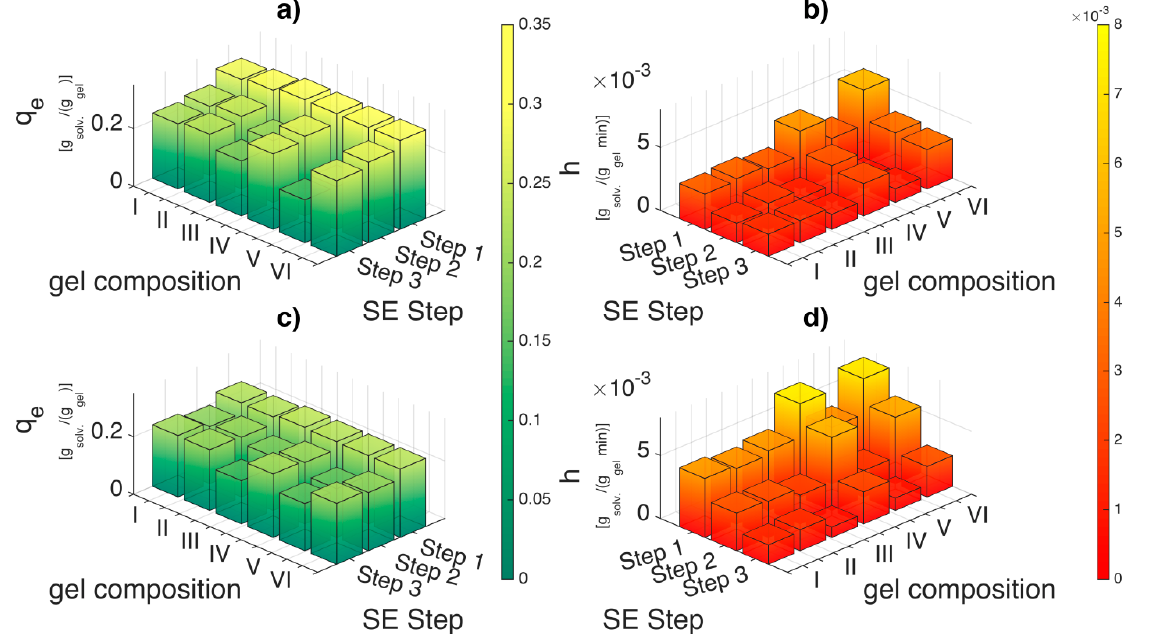
(Figure 10) with water trapped in its pores. With increasing biopolymer concentration, the tortuosity increases and also there might be additional resistances in the form of surface adsorption, hydrogen bonding or water dissolution in the matrix resulting in decrease in the sorption rates.